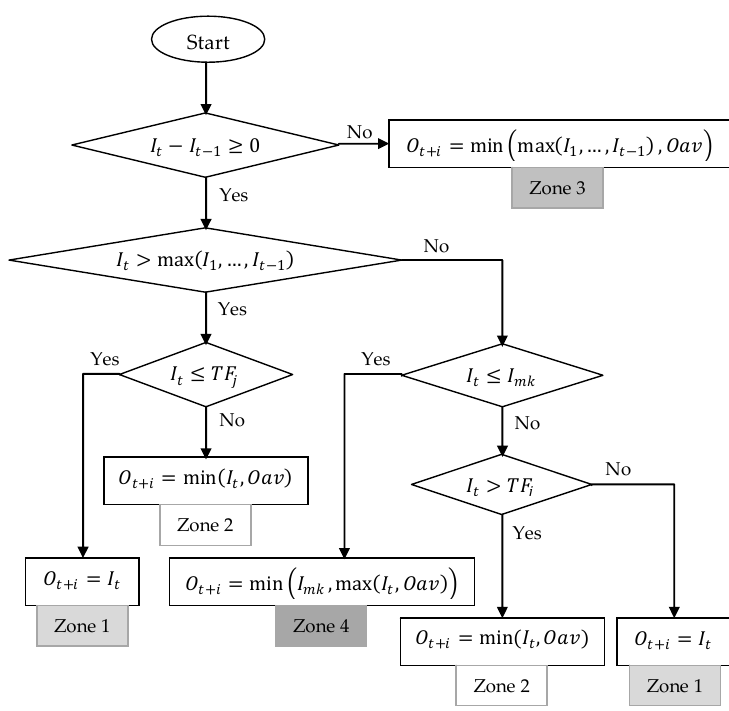
Figure 6. Scheme of the selection procedure of the forecast discharge flow according to the zoning of the input hydrograph.